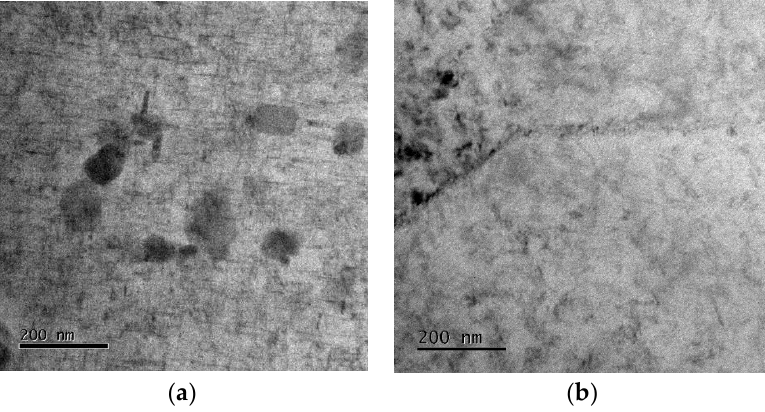
Figure 6. TEM images of untreated ( a ) and treated ( b ) AA2014-T6.